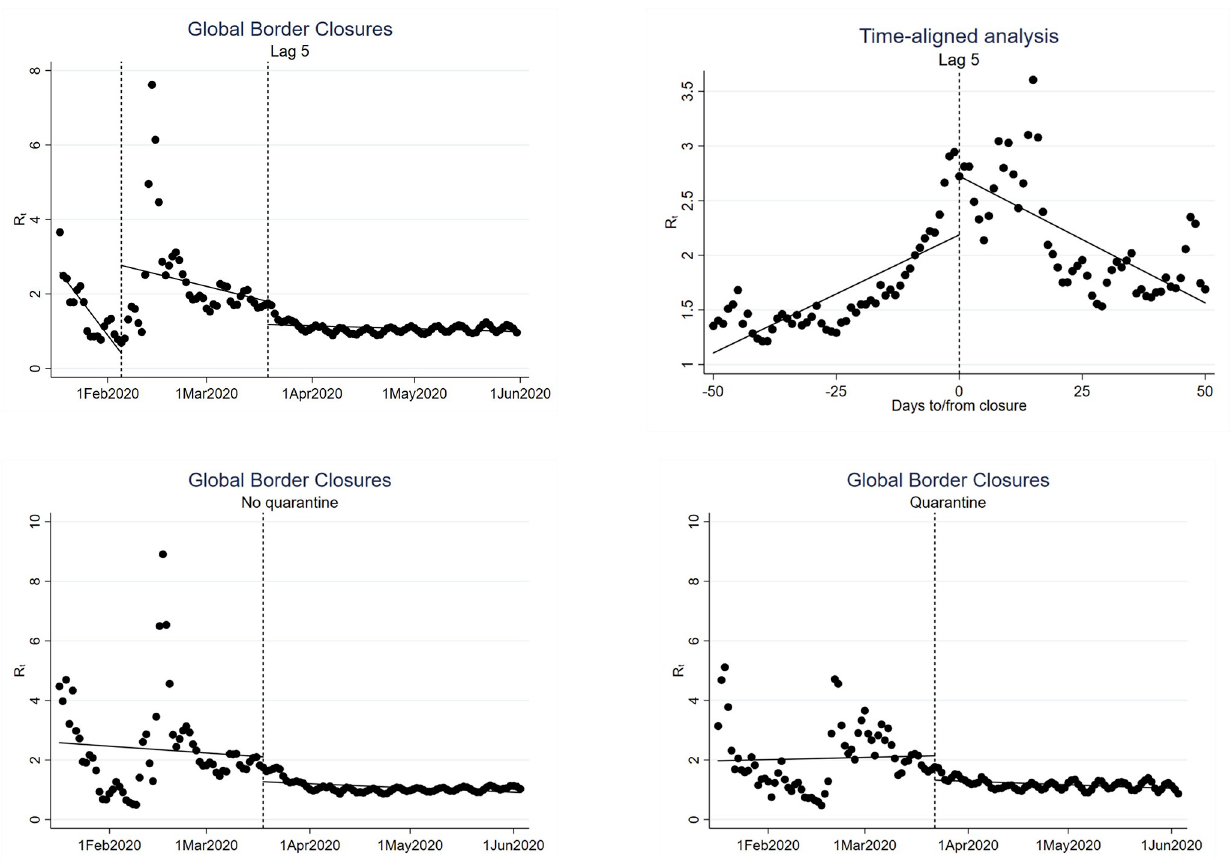
Fig 2. Interrupted time-series analyses of global R t , excluding China. Time-series analyses of: i) impact of the first global intervention of targeted border closures on February 5, 2020, followed by the second global intervention of total border closures on March 19, 2020; ii) time-aligned analysis of the intervention date for all countries that only implemented total border closures; iii) impact of the global intervention of total border closures for countries that had not implemented quarantine measures for international travellers (March 18, 2020); and iv) impact of the global intervention of total border closures for countries that had implemented quarantine measures for international travellers (March 22,